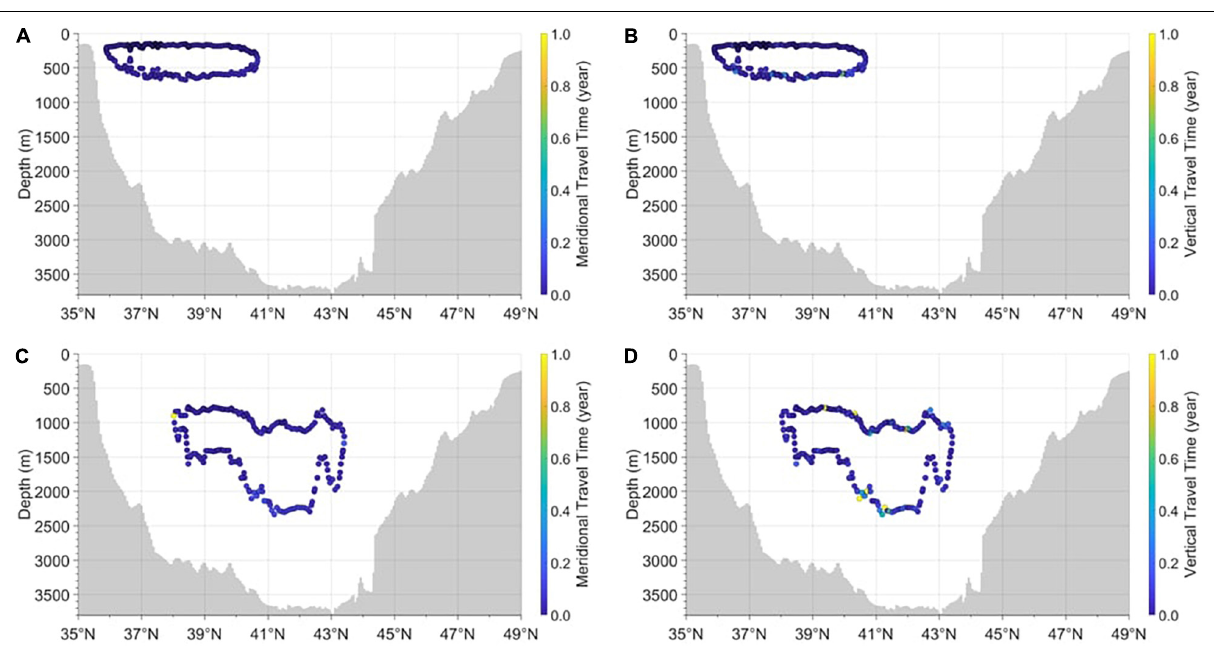
FIGURE 8 | Meridional and vertical travel times of 0.2 Sv (A,B) and − 0.3 Sv (C,D) streamlines for the shallow convection case in the meridional overturning stream function. Turnover times of the 0.2 Sv (A,B) and − 0.3 Sv (C,D) streamlines are 8.68 years (= 2.22 + 6.46) and 36.76 years (= 9.98 + 26.78),